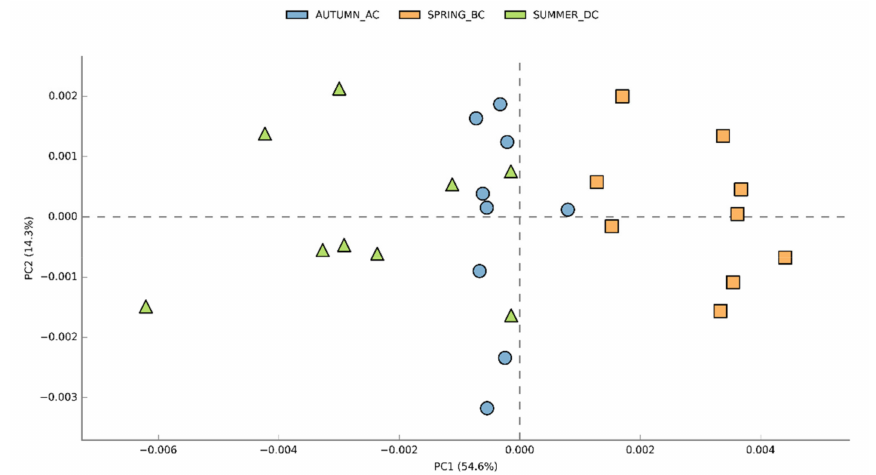
Figure 6. Principal Component Analysis (PCA) of the functional diversity among nine fields across three seasons: Spring_before cultivation (BC), Summer_during cultivation (DC), Autumn_after cultivation (AC). The different seasons are depicted in different colours and